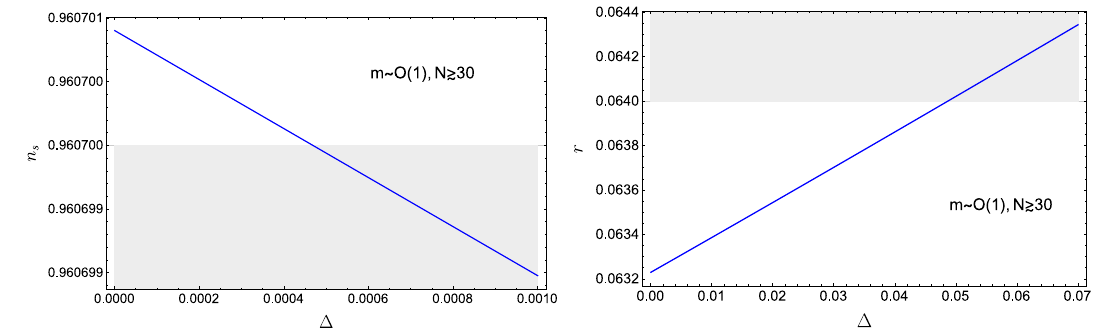
Fig. 1 Plotof n s (leftpanel)and r (rightpanel)versustheBarrowparameter (cid:2)